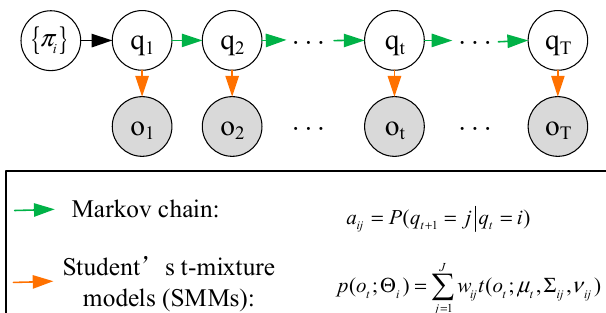
Figure 3. A graphical illustration of Student’s t-HMM. The Student’s t-HMM is defined as a finite state-space hidden Markov model whose observation emission distributions of each hidden state are modeled by Student’s t-mixture models (SMMs). Suppose that one Student’s t-HMM has I hidden states, and the